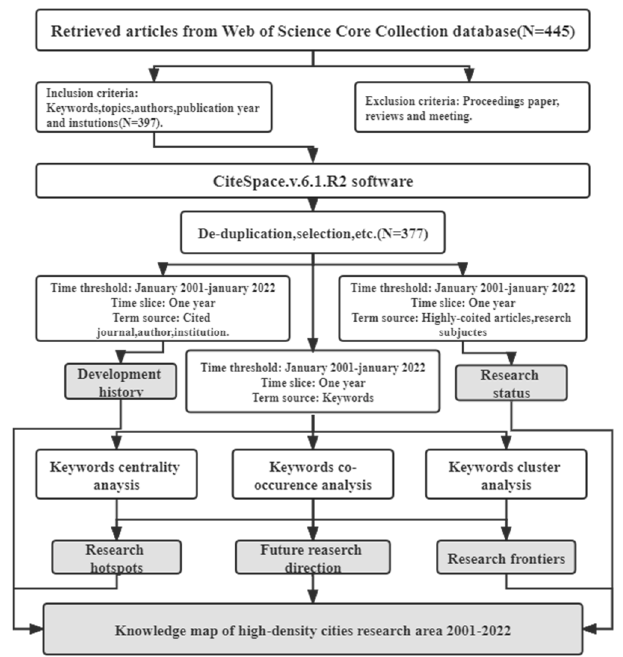
Figure 1. Outline of high-density city research design.